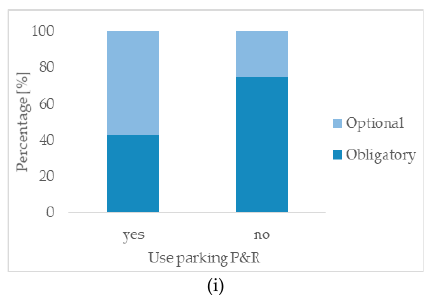
Figure 13. Characteristics of respondents using and not using P&R parking in Cracow depending on the following characteristics of the respondents: ( a ) gender; ( b ) age; ( c ) education; ( d ) monthly